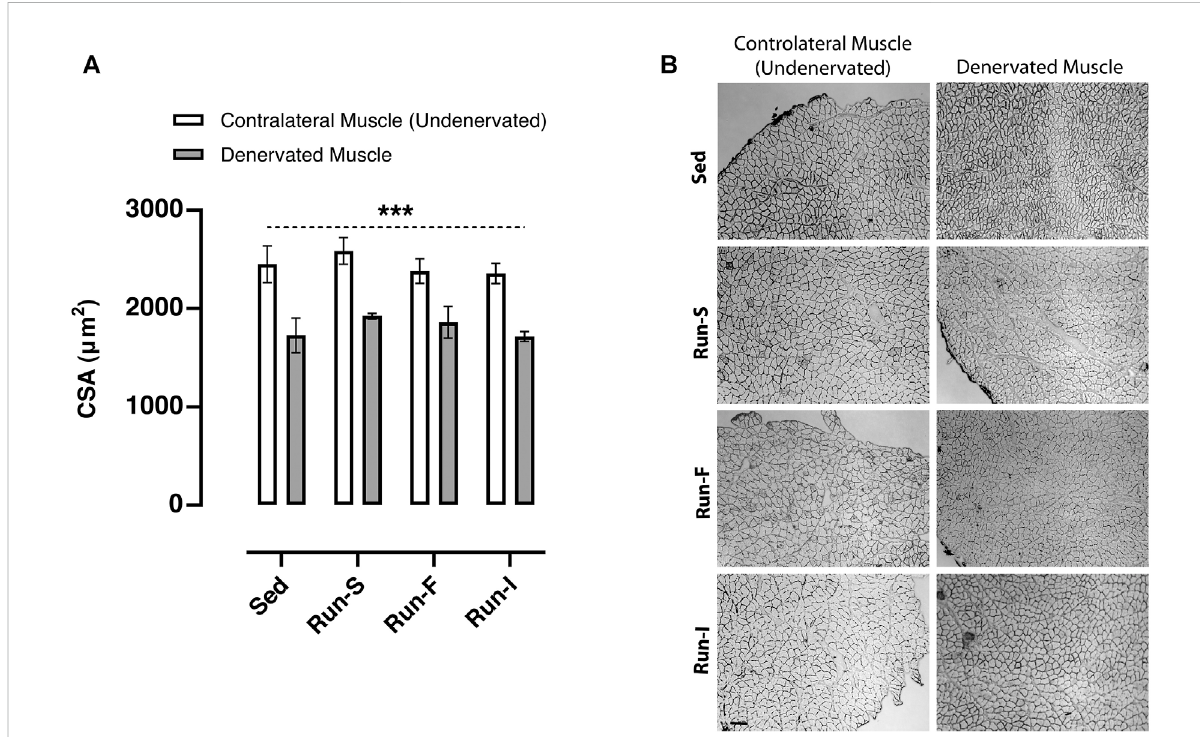
FIGURE 4 Effect of different exercise protocols on thecross-sectionalarea of soleus muscle fi bers after nerve crush. (A) Cross-sectional area determined inSed,Run-S,Run-F,andRun-Isoleusmuscle.Two-wayANOVA,maineffecttypeofexercise: F (3,16)=1.002, p =0.417;maineffectofdenervation: F (1, 16) = 46.57, p < 0.001; type of exercise-by-denervation interaction effect: F (3, 16) = 0.2077, p = 0.890. *** p < 0.001 indicates the main effect of denervation with respect to thecontralateral side(undenervated)ineach group. Data areexpressedas meanand SEM(denervatedmuscle: